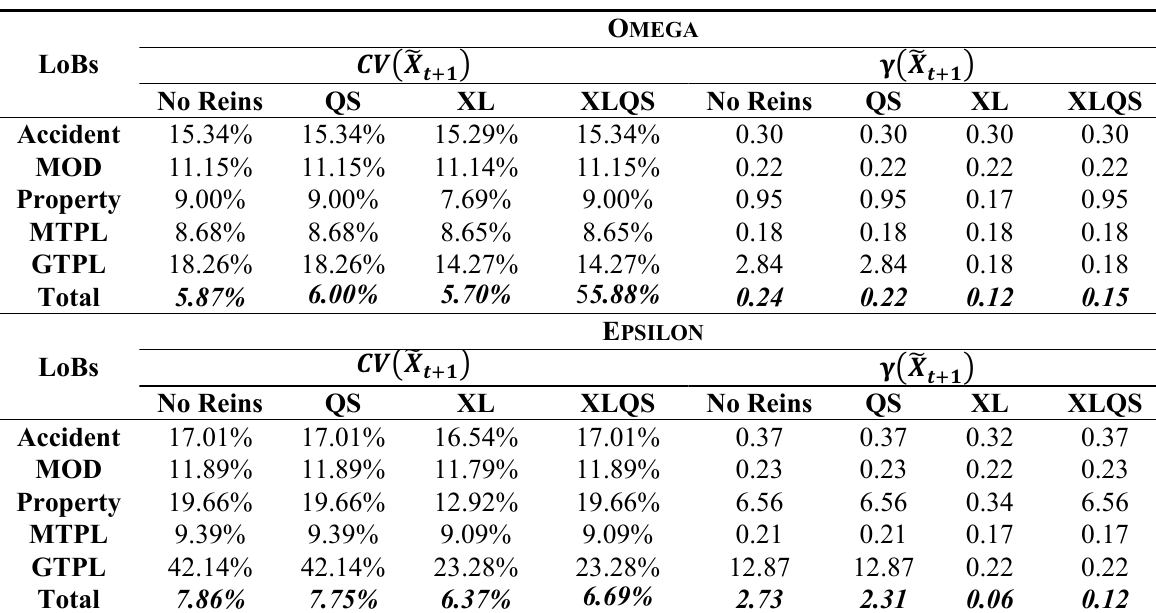
Figure 2. Distribution of aggregate claim amount of Total Portfolio for E PSILON according to different reinsurance strategies. Table 6. CV and skewness of simulated distribution for each LoB (Gross and Net of